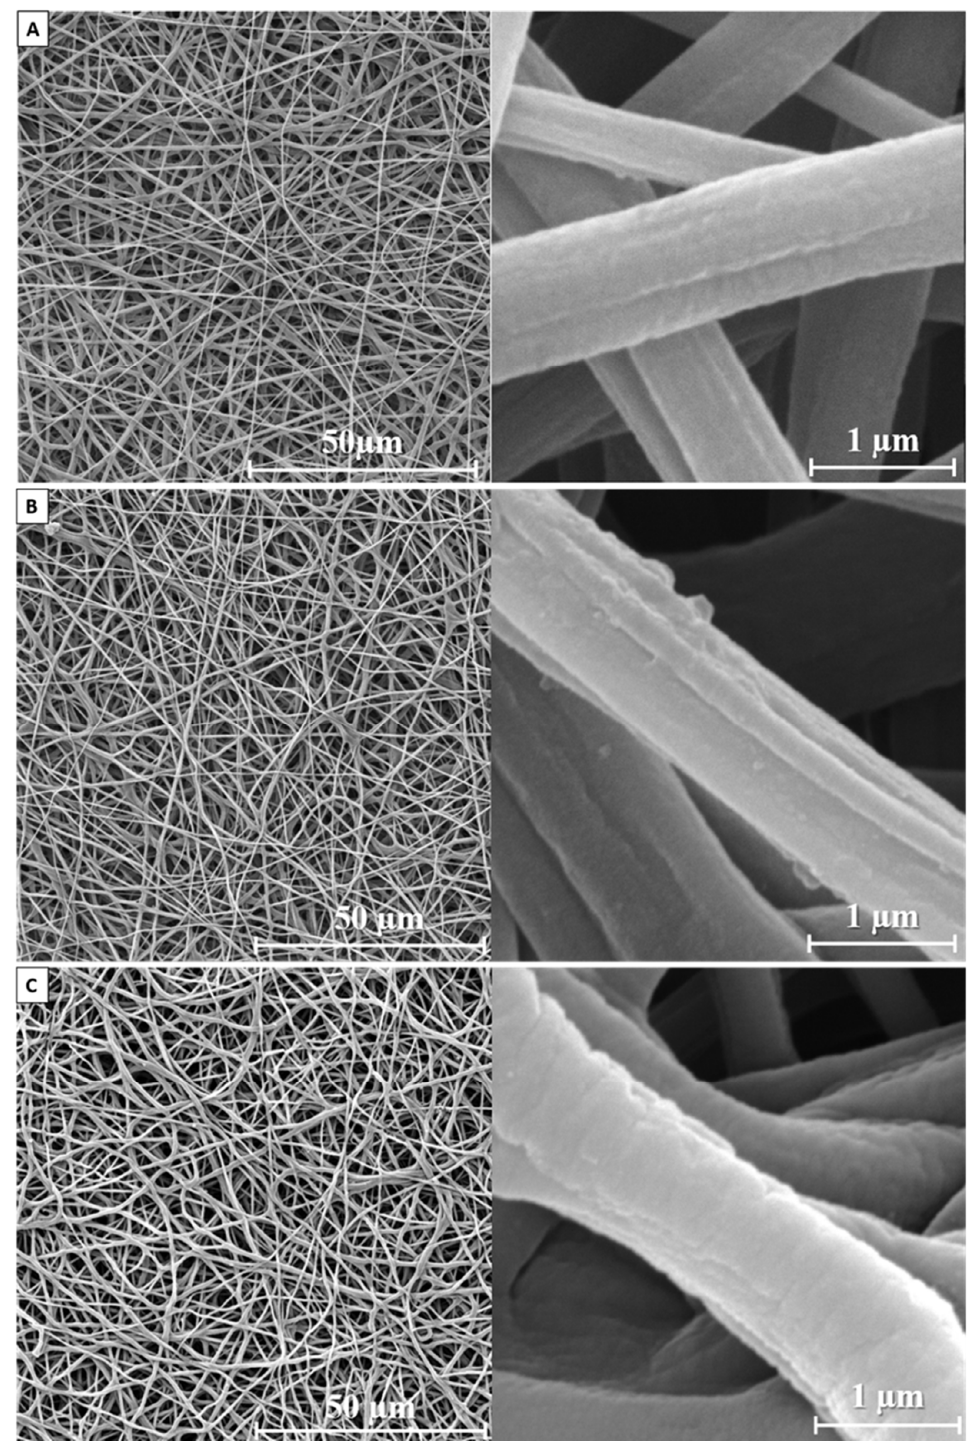
Figure 2. SEM images of the front membrane surface: ( a )—non-treated, ( b )—150 V, ( c )—300 V.